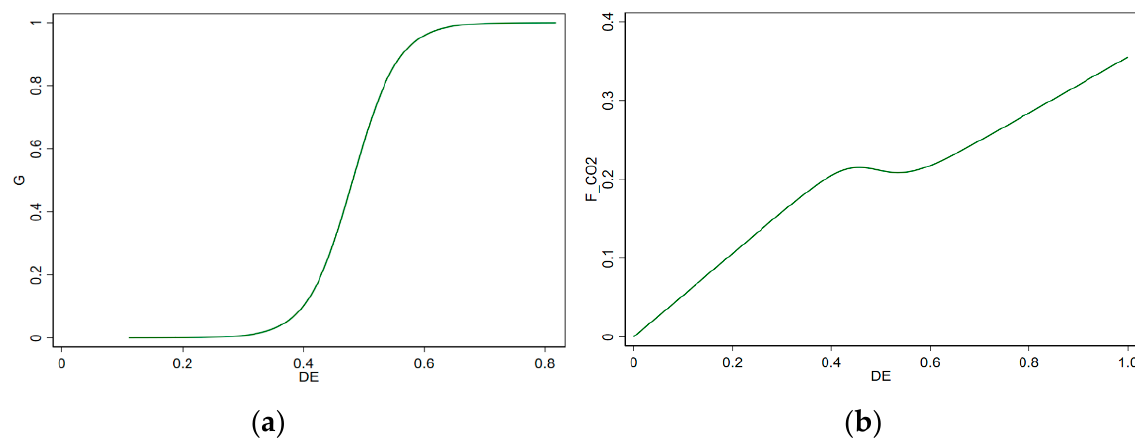
Figure 2. ( a ) The transition function; ( b ) Digital economy and decoupling coefficient.